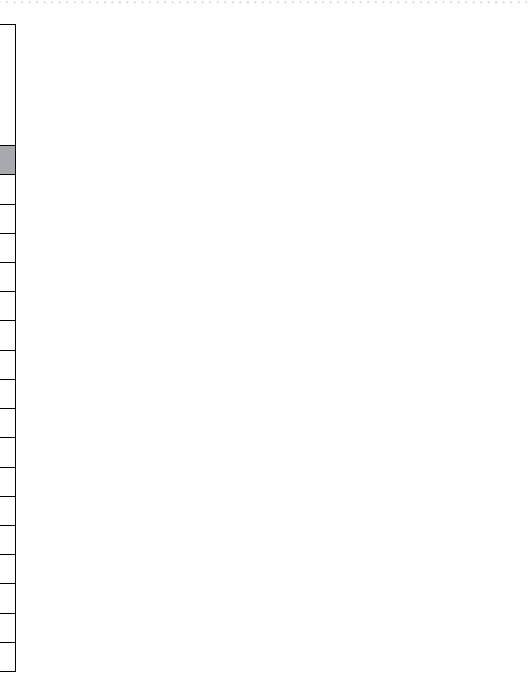
Table 1. In vitro α-glucosidase inhibitory activities of compounds 8a–p